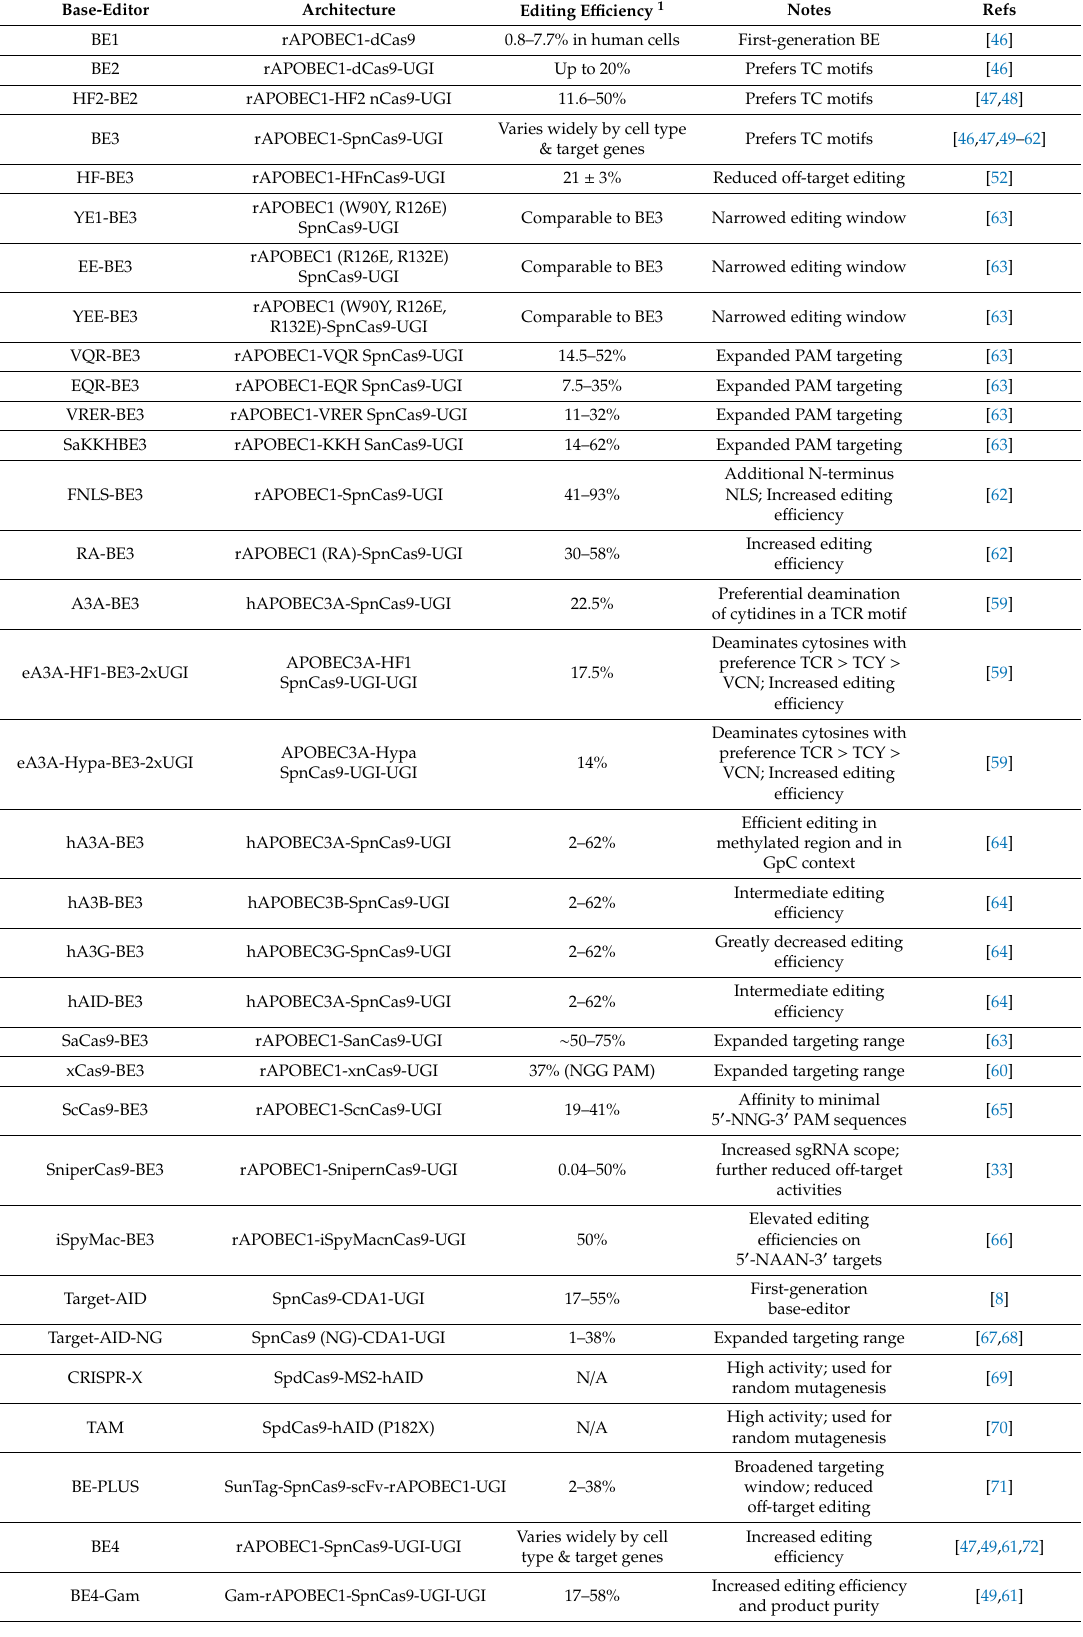
Table 1. Comparison of CRISPR-Base-editing